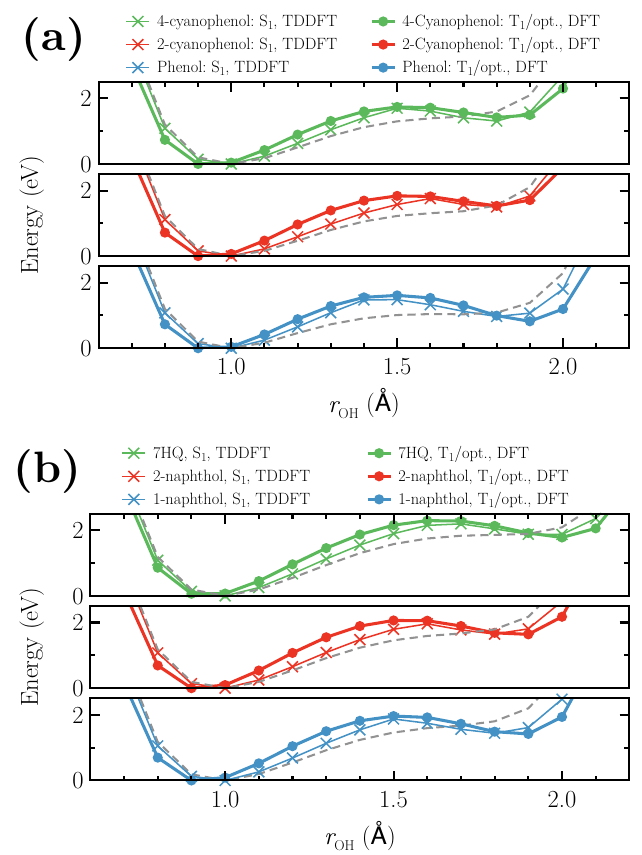
Figure 3. Proton dissociation curves for ( a ) phenol- and ( b ) naphthol-based photoacids. The reference data points obtained using TDDFT at S 1 states are shown as crosses. DFT results at T 1 state with the additional optimized effective potentials for the acidic hydrogens are shown as solid circles. Gray dashed lines show the dissociation curves obtained at T 1 states without any additional